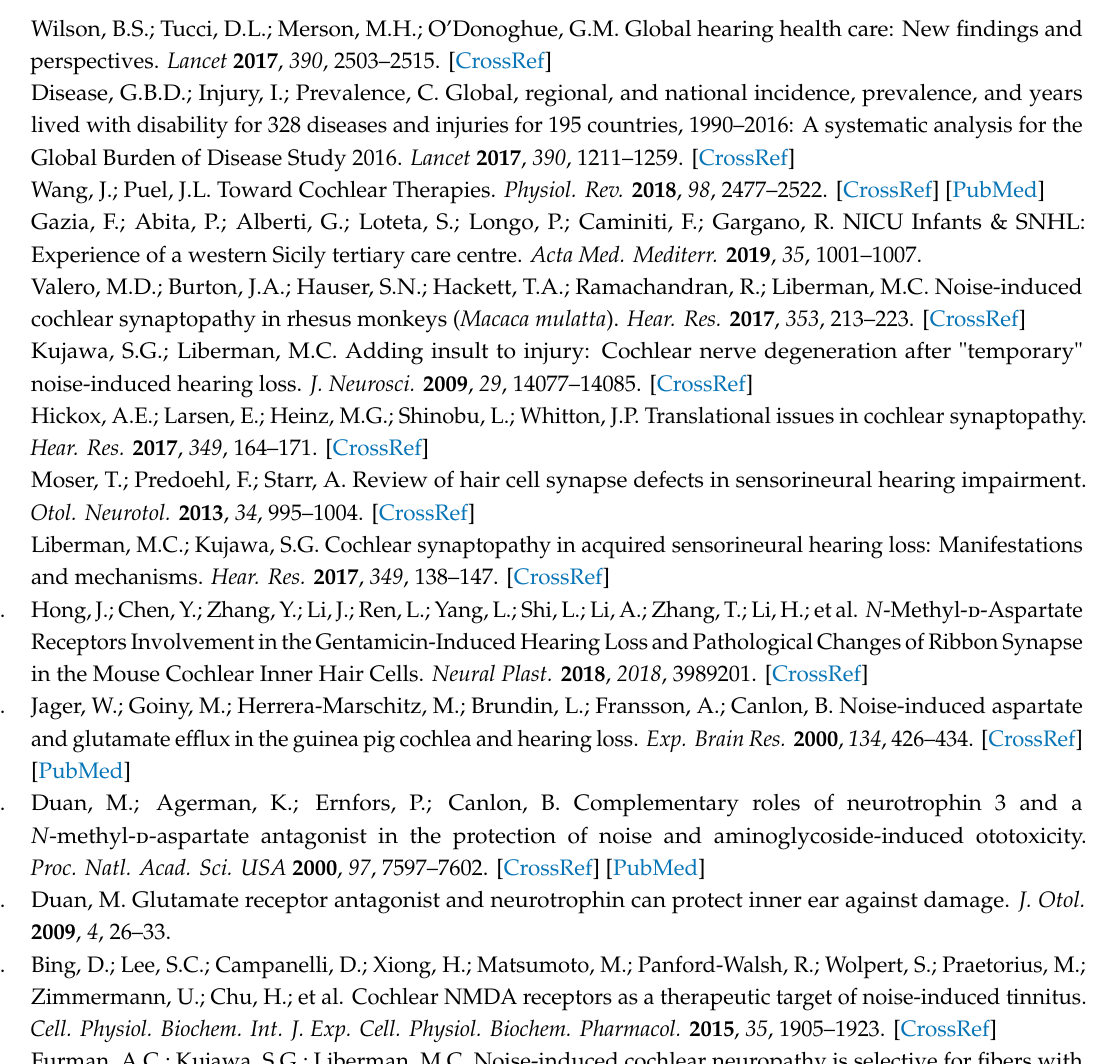
Table S1: Factors of hearing loss by using Cox